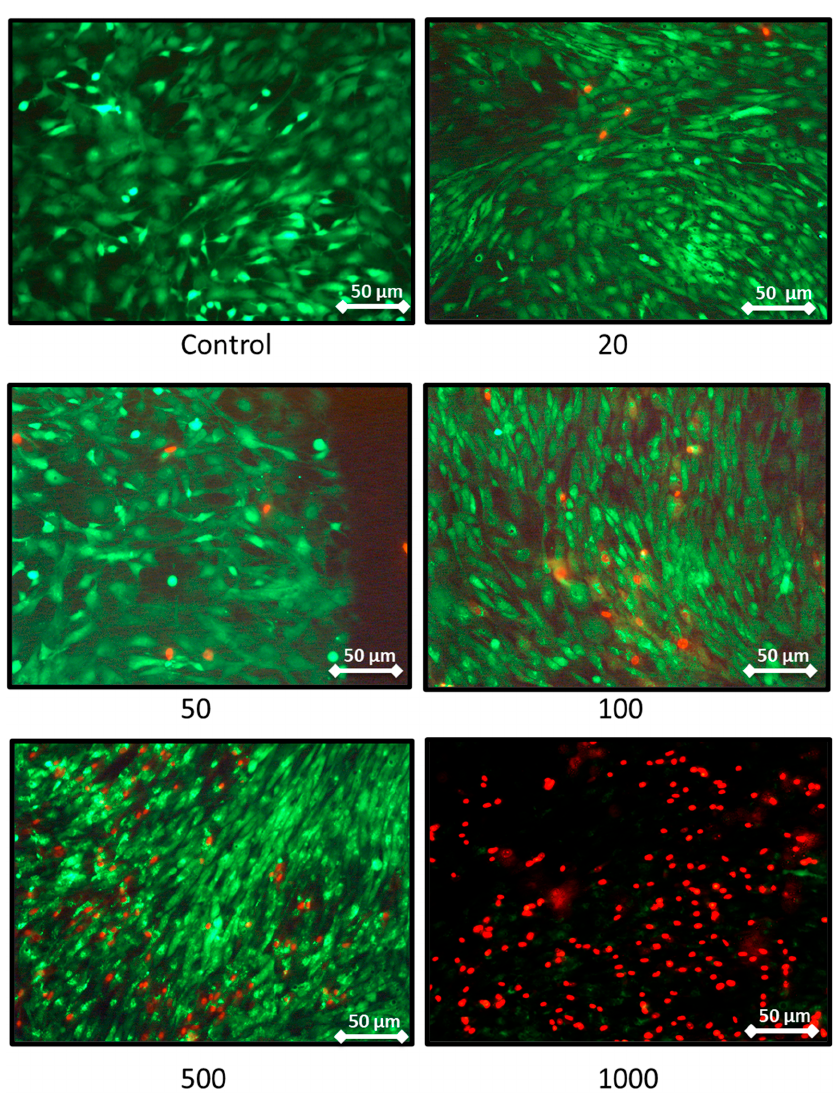
Figure 4. Representative pictures showing the effect of nanoliposome exposure on chondrocytes death. Rat chondrocytes were exposed to increasing concentrations of nanoliposomes (20, 50, 100, 500, and 1000 µg/mL) for 7 days. Live/Dead Cellular Viability/Cytotoxicity Kit from Sigma was used to differentiate live from dead cells. The experiment was performed four times with three biological replicates for each condition tested. Live cells are stained in green and dead cells in red. Immunofluorescence labeling was detected using fluorescence microscopy (DMI 3000B, Leica, Wetzlar, Germany) at 40×, exposure time was between 1 and 5 s. Scale bars on images represents 50 µm.